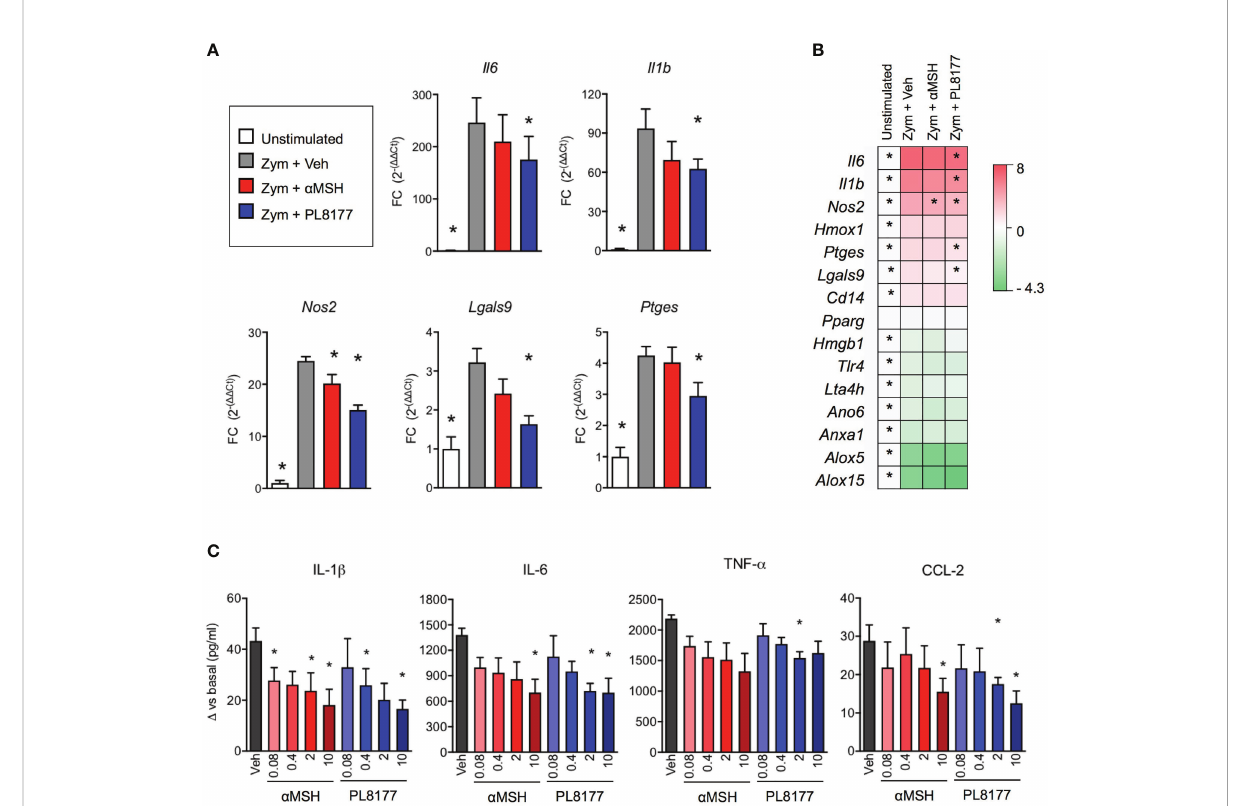
FIGURE 3 In vitro anti-in fl ammatory actions of PL8177 and a MSH on mouse primary macrophages. Biogel-elicited peritoneal macrophages were incubated for 30 min with Melanocortin compounds prior stimulation with zymosan (Zym, 25 m g/ml) for further 6 h. (A) Gene expression for in fl ammatory related genes was measured by real time-PCR on cells treated with vehicle (Veh) or with 2 m M of PL8177 or a MSH. Unstimulated cells were used as control for normalization. Fold changes (FC) were calculated as 2 (- DD Ct) , using Gapdh as reference gene (B) Summary of gene expression measurements, including genes that were not signi fi cantly altered by the treatments, expressed as log 2 FC. (C) Concentration- response effect of PL8177 and a MSH (0.08-10 m M) on cytokine release by macrophages measured by ELISA. For all experiments, 5 mice were used and analyzed by repeated measures one-way ANOVA followed by multiple comparison test. Data represent mean ± SEM. * p <0.05 vs. zymosan alone